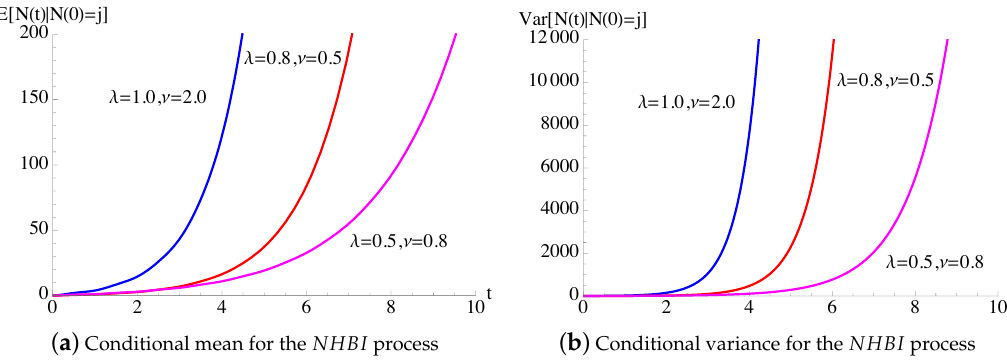
Figure 8. For the NHBI process of Figure 7, the conditional mean and the conditional variance (44) are plotted as function of t for j = 0, a = 0.9, Q = 1.0 and for some choices of λ and ν